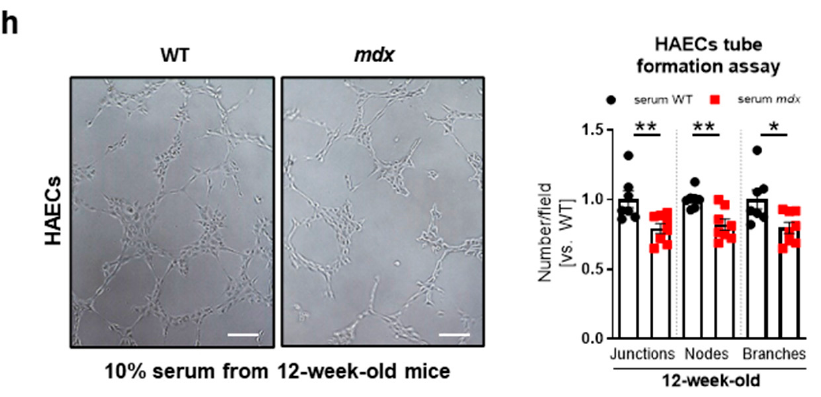
Figure 1. Alterations in angiogenesis markers in Duchenne muscular dystrophy (DMD) models. ( a ) The expression of Kdr , Cxcl12 , Ang1 , Ang2 , and Tie2 is decreased, whereas Cxcr4 is increased in the gastrocnemius of 6-week-old mdx mice; qRT-PCR; n = 8–12/group. ( b ) In the diaphragm of 6-week-old dystrophic mice, the mRNA transcripts of Kdr , Cxcl12 , Ang2 , and Tie2 are downregulated, whereas Cxcr4 is upregulated, qRT-PCR; n = 11–12/group. ( c ) The expression of Kdr , Ang2 , Cxcl12 is decreased, whereas Cxcr4 , Cxcl1 , Mmp11 is increased in the gastrocnemius of 12-week-old mdx mice; qRT-PCR; n = 4–13/group. ( d ) In the diaphragm of 12-week-old dystrophic mice, the mRNA transcripts of Ang1 , Ang2 , and Tie2 are lower, whereas Cxcr4 and Mmp11 are upregulated; qRT-PCR; n = 5–8/group. The downregulated level of vascular endothelial growth factor (VEGF) protein is found in the dystrophic gastrocnemius (Gastro), diaphragm (Diaph), and tibialis anterior (TA) muscle of ( e ) 6-week-old and ( f ) 12-week-old animals; enzyme-linked immunosorbent assay (ELISA); n = 5–8/group. ( g ) Decreased expression of VEGF is present in the dystrophic (DMD) human induced pluripotent stem cells (hiPSC)-derived skeletal muscle cells in comparison to control (Ctr) cells; qRT-PCR; n = 5–7/group. ( h ) Human aortic endothelial cells (HAECs) tube formation is decreased in the presence of a medium containing 10% serum from 12-week-old mdx mice as presented in representative photos of tubular structures on Matrigel with quantification of nodes, junctions, and branches, formed by the cells after 5 h of incubation either with wild-type (WT) or mdx -mice derived serum; a microscopic assessment using a Nikon Eclipse microscope followed by ImageJ quantification using an Angiogenesis Analyzer. Scale bar: 100 µ m; n = 7–8/group. The results are presented as mean ± SEM. * p < 0.05, ** p < 0.01, *** p < 0.005, **** p < 0.0001 with unpaired two-tailed Student’s t -test.